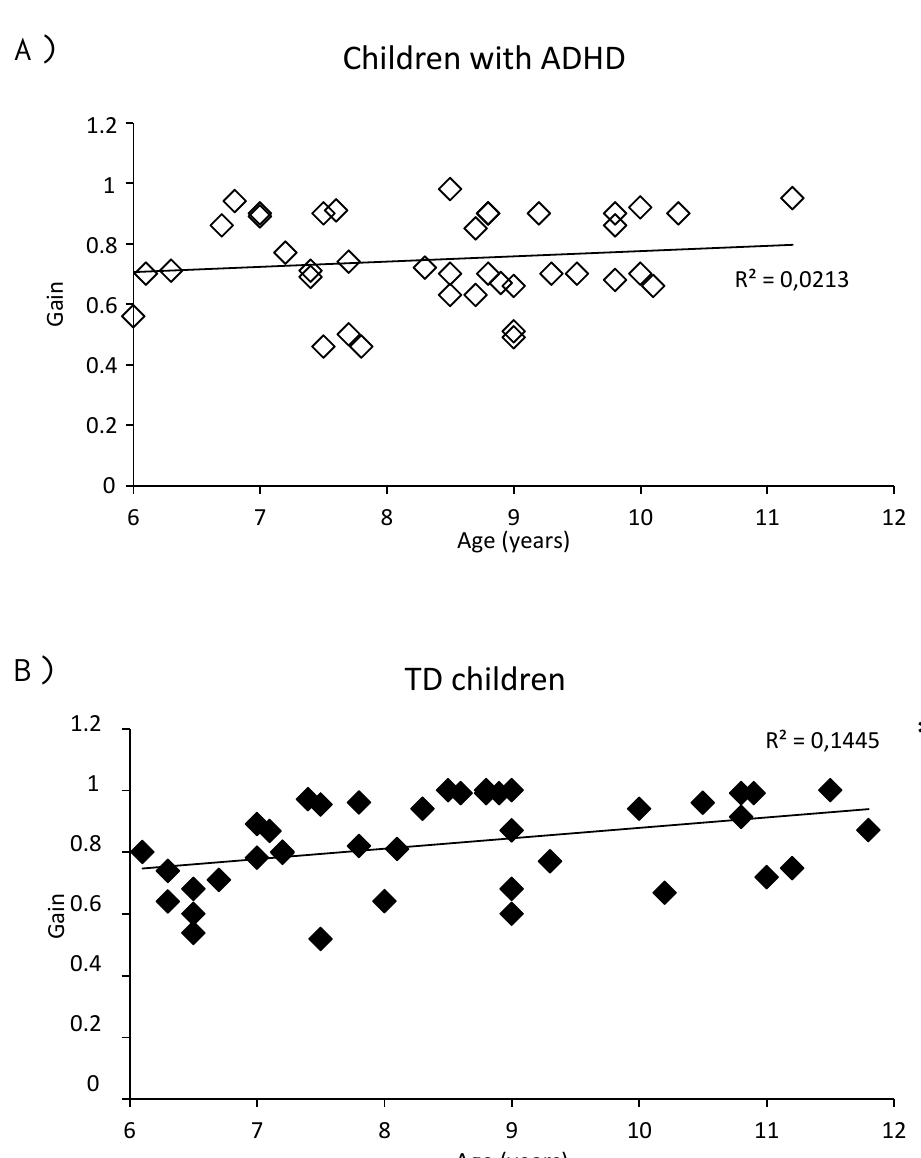
Figure 2. Pursuit gain made by children with ADHD ( A ) and TD children ( B ) in correlation with their chronological age at inclusion. Line represents the corresponding regression by age. *: p <